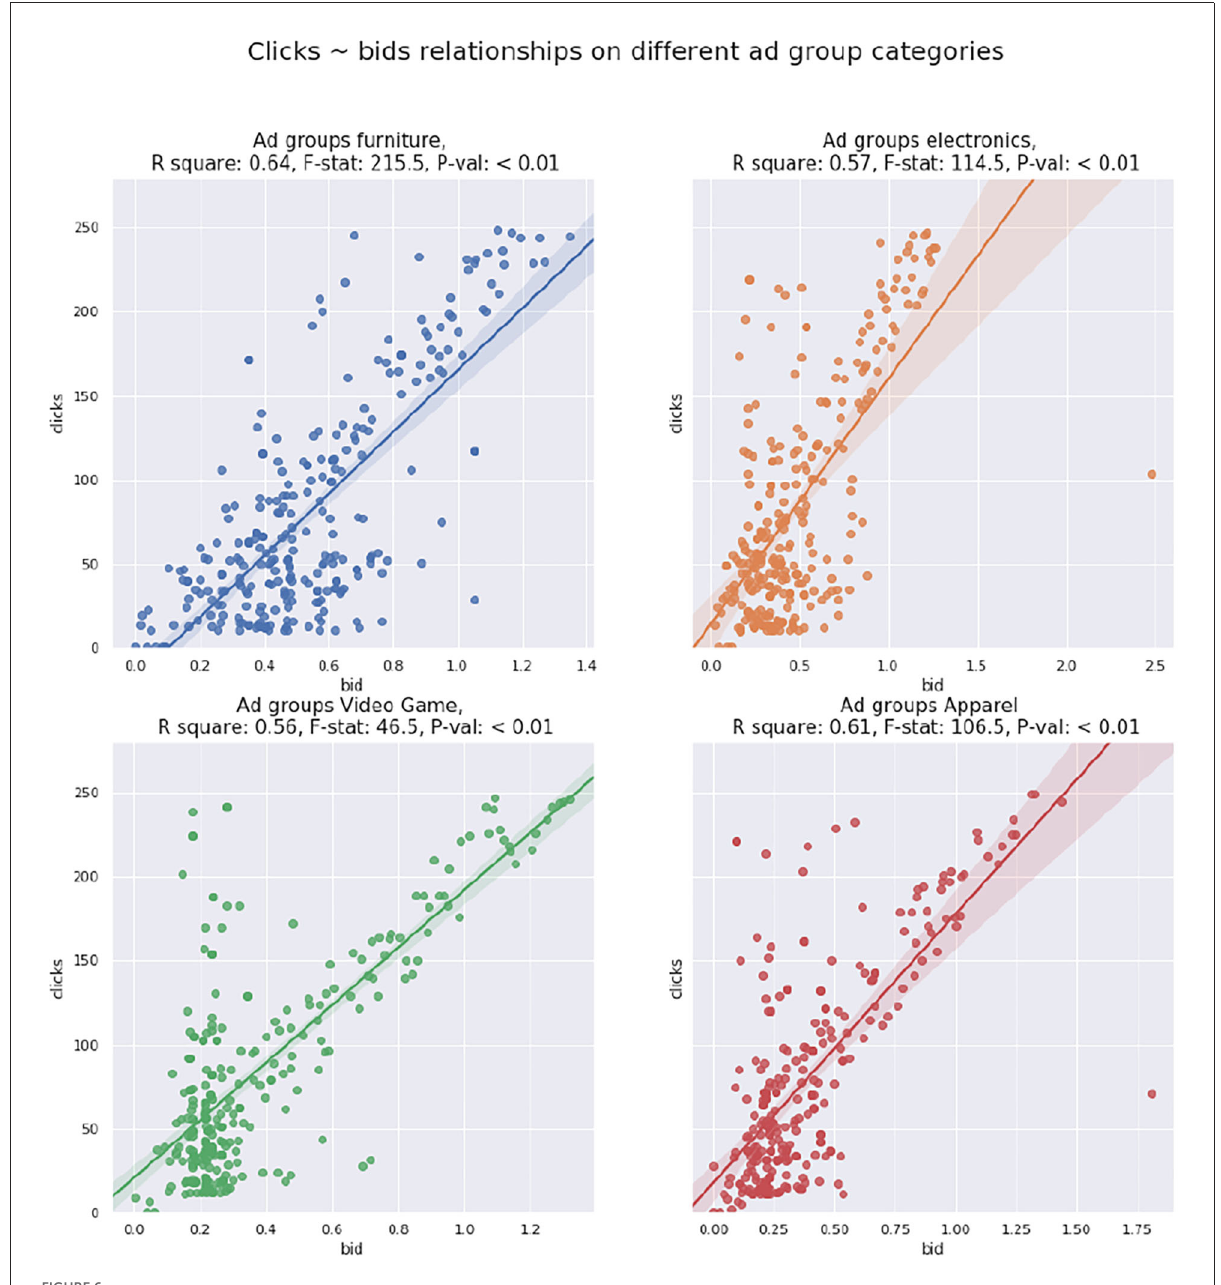
FIGURE6 Clicks bids scatter plot with regression line for product types of ad